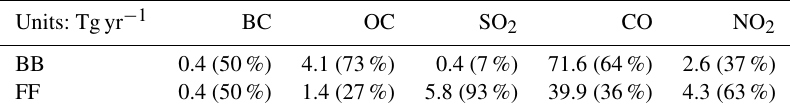
Table 1. Mean annual emissions of BC, OC, SO 2 , CO, and NO 2 from biomass burning emission (BB) and fossil fuel burning emission (FF) in the simulated domain from 2002 to 2008. Parentheses show the percentage of emission from fire and non-fire sources. Units: Tgyr − 1